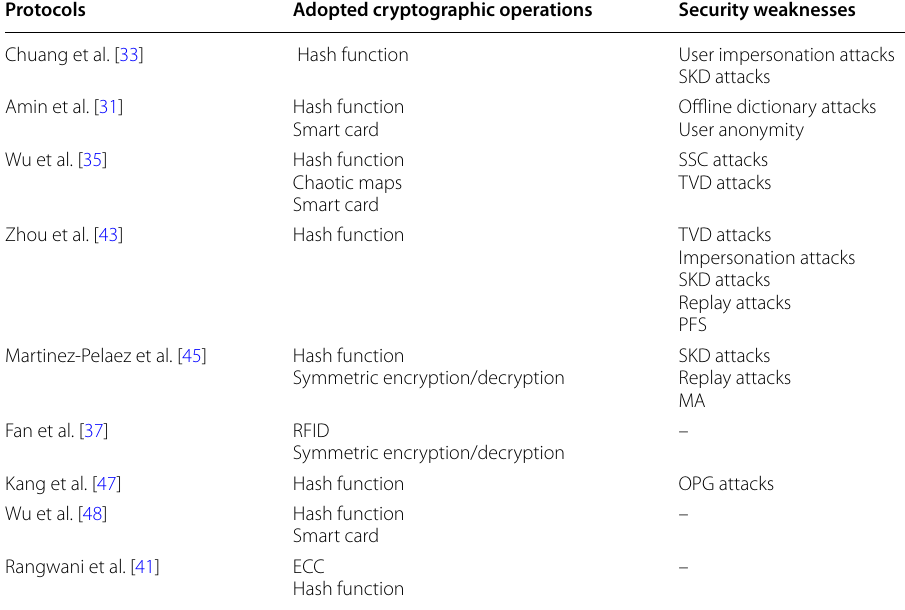
Table 1 Overview of authentication protocols